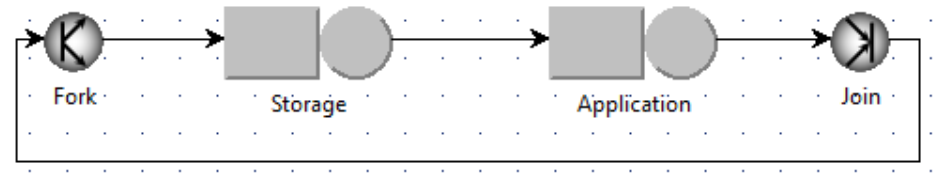
Figure 8. Minimum number of used VMs with synchronous access.